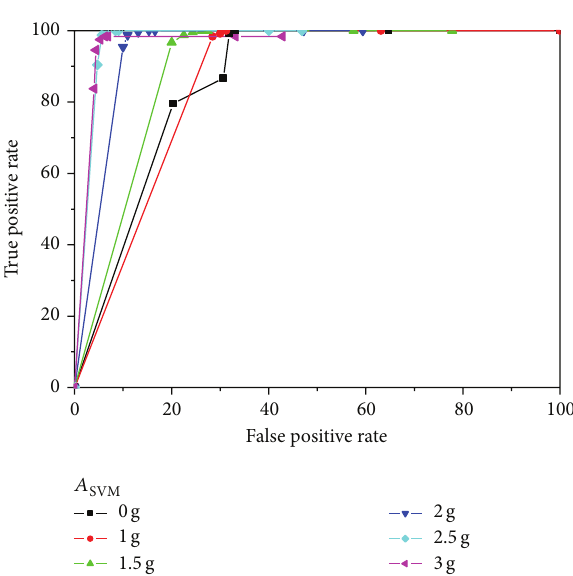
Figure 4: ROC curve of fall detection obtained from the simple threshold using the single fall-feature parameter. The best fall detection is of sensitivity 92.92%, specificity 81.56%, and accuracy = 2.5 g. 88.05% when 𝐴 GSVM